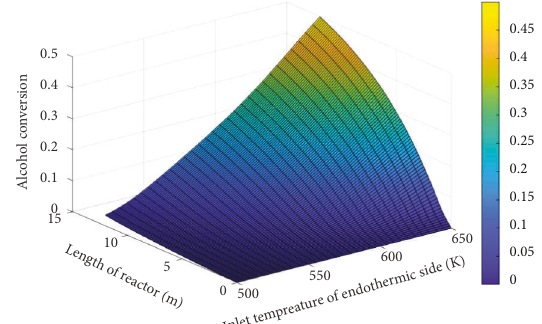
Figure 5: Effect of temperature on the endothermic side of the reactor on conversion percentage of 2-butyl alcohol and MEK yield.